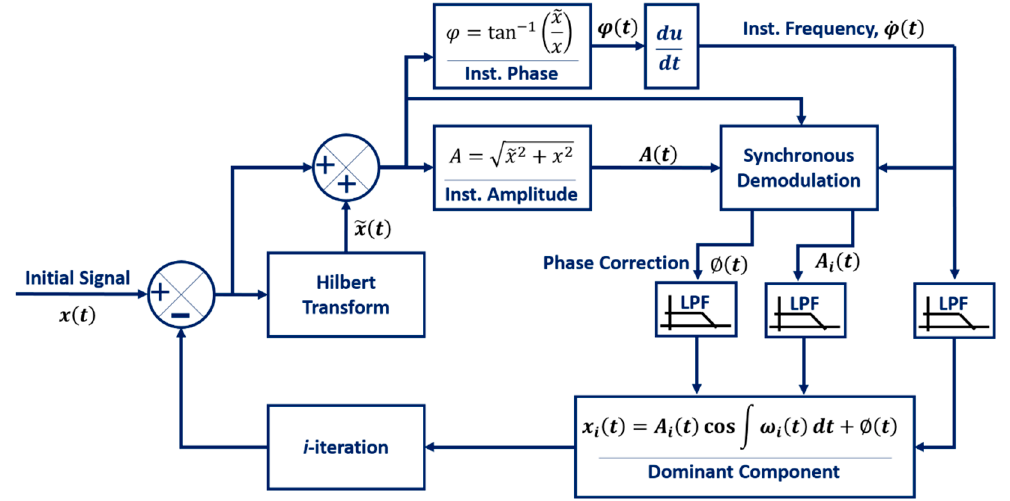
Figure 1. The HVD procedure for extracting a multicomponent vibratory signal.